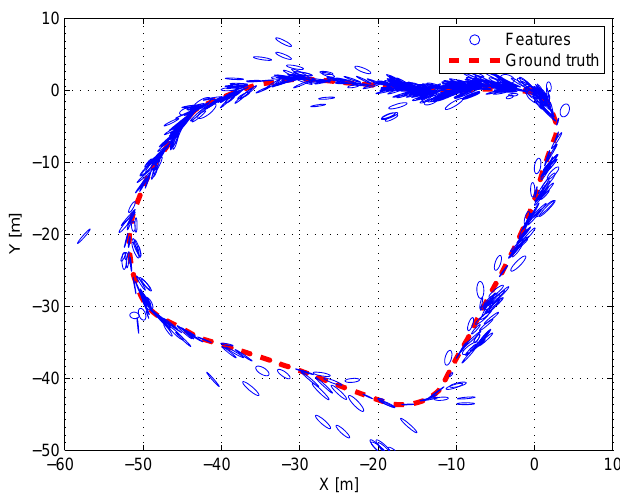
Figure 11. Top view of the outdoor environment. Blue circles denote the covariance of features and the red dots denote the ground truth of the robot’s trajectory.